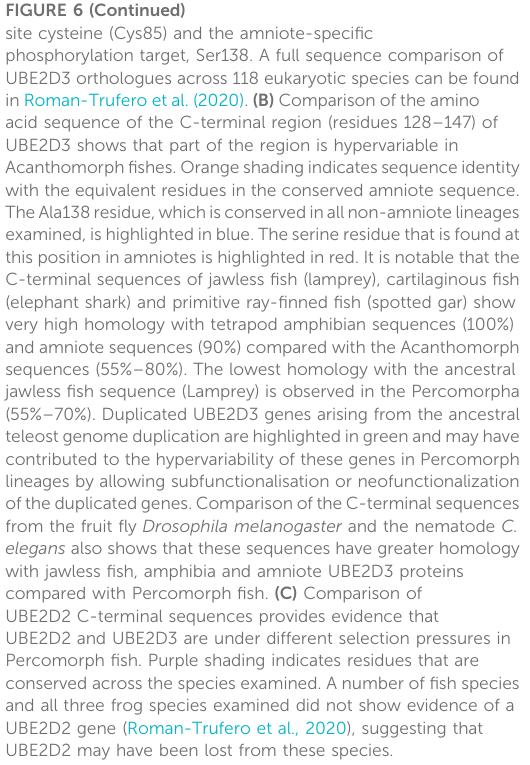
Comparison of the amino acid sequences of UBE2D3 orthologues across multiple eukaryotic lineages. (A) Comparison of the complete human UBE2D3 sequence with vertebrate and non-vertebrate orthologues. Grey shaded boxesindicateresiduesthatarecompletelyconservedacrossallof the species shown. Vertical arrows indicate the conserved active